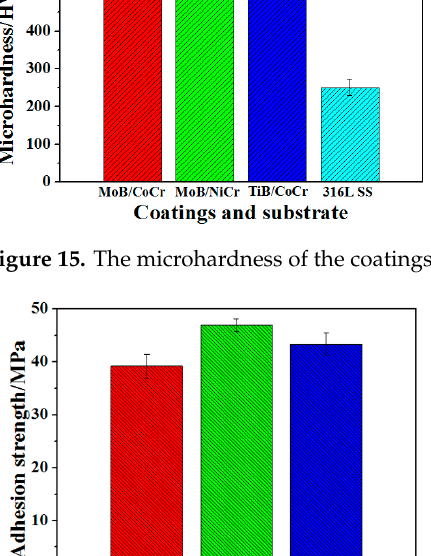
Figure 16. Bond strength of the coatings.